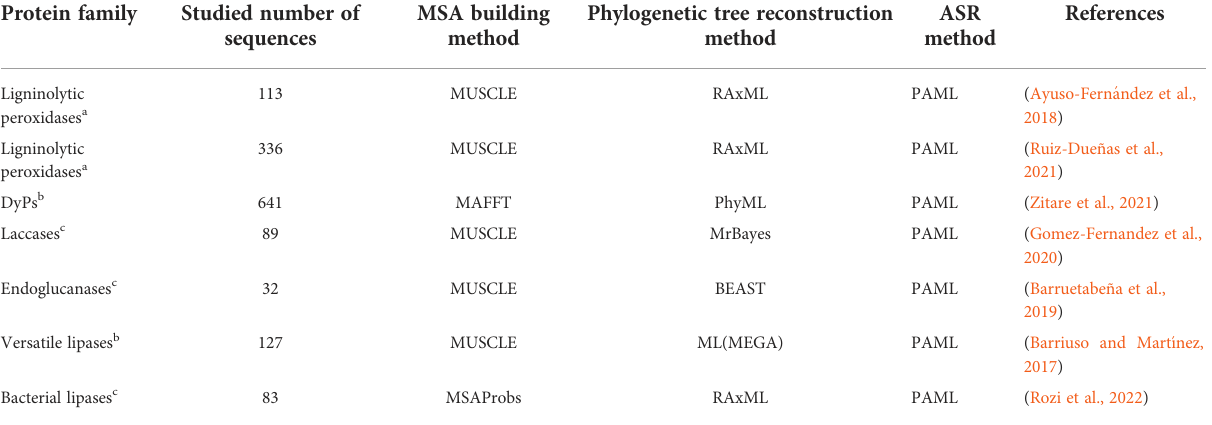
TABLE 2 Summary of PCWDE works using ASR, and the methods used by the